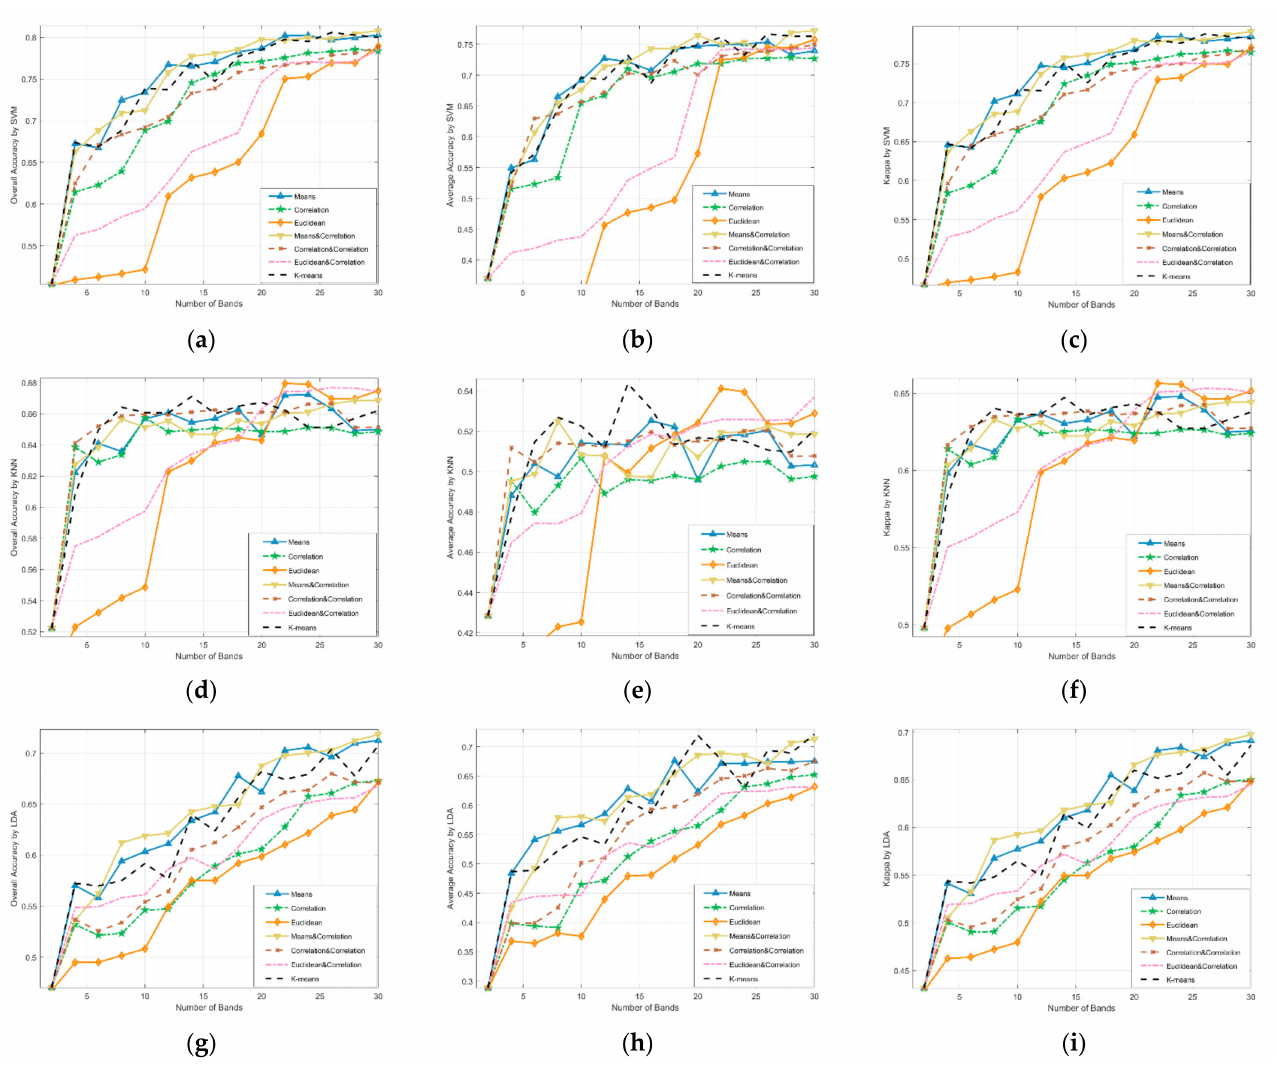
Figure 8. Classification accuracy of different subspace partitioning methods. ( a – i ) are OA, AA and Kappa Results by SVM, KNN and LDA